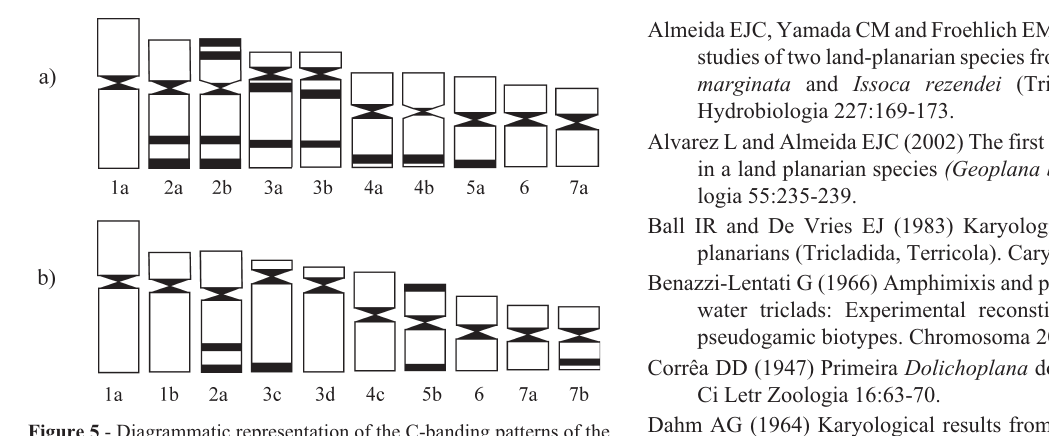
Figure 5 - Diagrammatic representation of the C-banding patterns of the chromosomes of the diploid (a) and triploid (b) karyotypes of Dolichoplana carvalhoi .